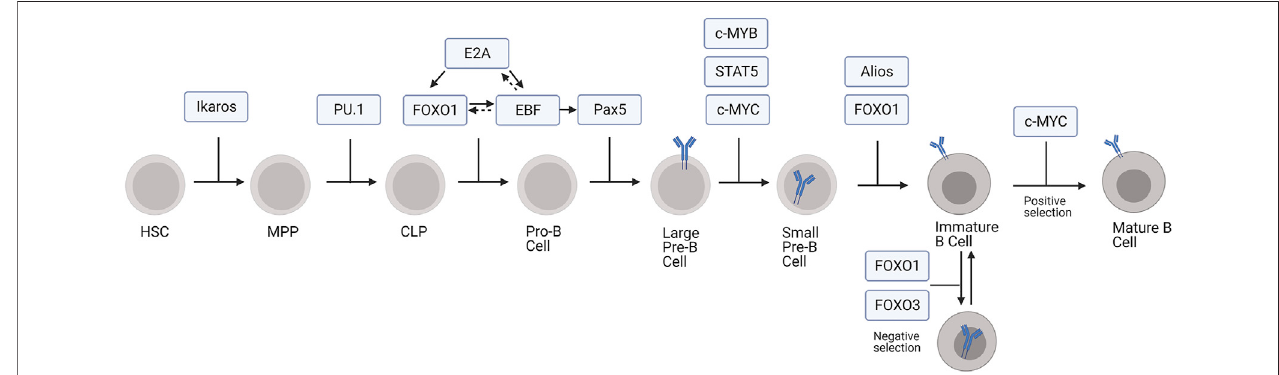
FIGURE 1 | Transcription factors regulating development of B cells from HSCs. In this model, MPP includes both LMPP and ELP